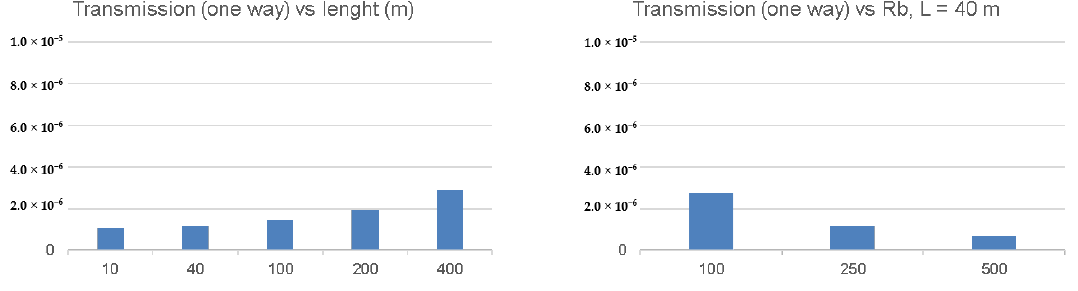
Figure 4. Sensitivity of transmission time to line length, bit rate, and the number of 16-bit words.